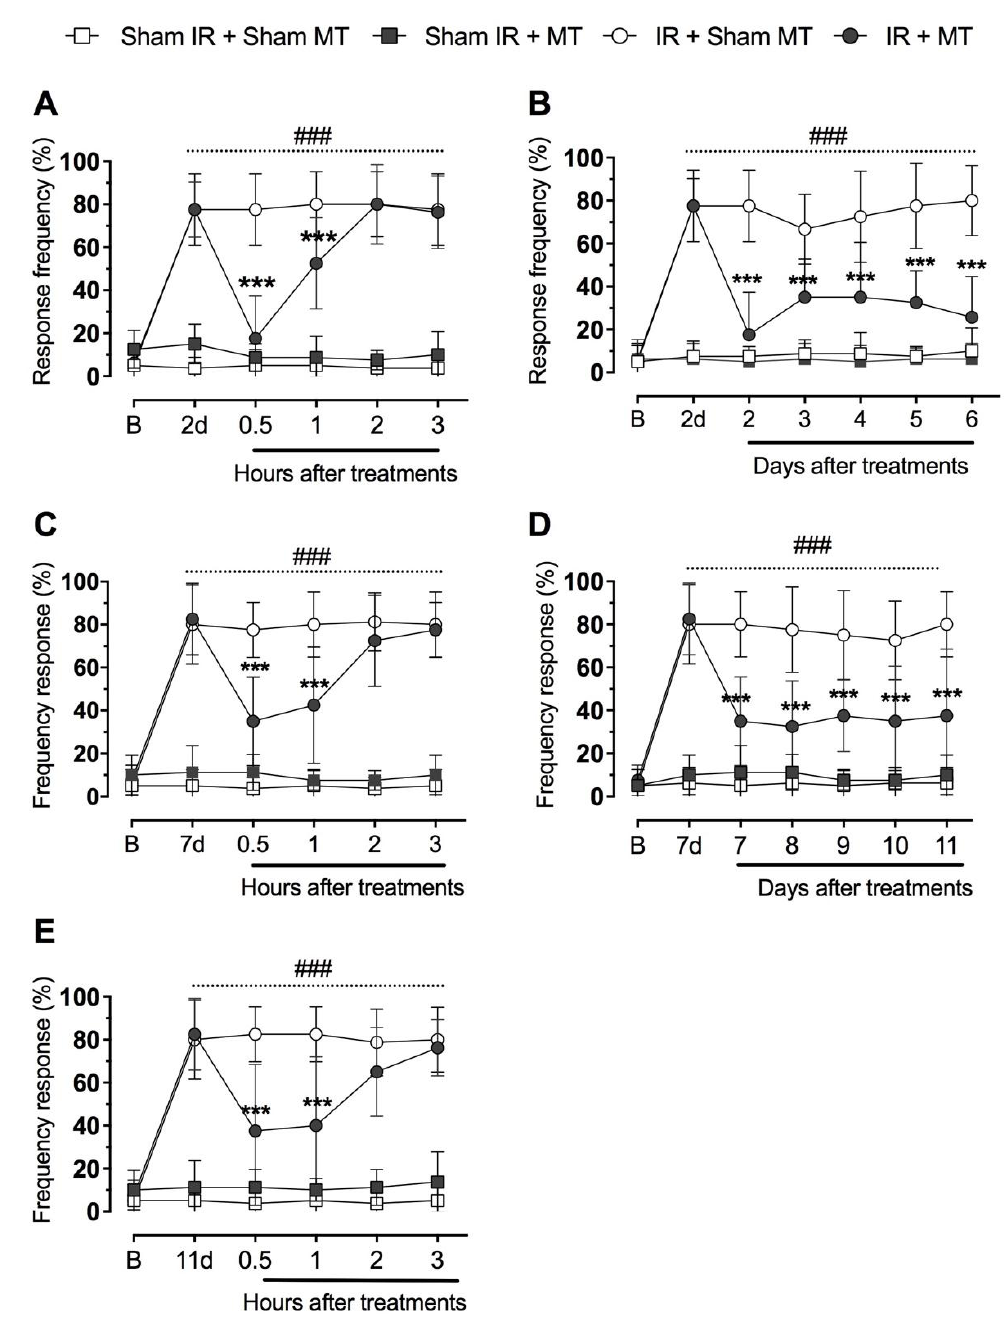
Figure 2. E ff ect of manual therapy (MT) on mechanical hyperalgesia. Time course analysis at the 2nd day (panel A ). Daily treatment with 9-minute ankle joint mobilization between the 2nd to 6th day after IR procedure (panel B ). Time course analysis at 7th day (panel C ). Daily treatment with 9-minutes of MT between the 7th to 11th day after IR procedure (panel D ). Time course analysis at 11th day (panel E ). Each point represents the mean of 8 animals and vertical lines show the SD. Statistical analyses were performed by two-way ANOVA followed by Bonferroni test. The symbols denote a significant di ff erence of *** p < 0.001 when compared to IR + Sham MT group or ### p < 0.001 when compared to Sham + Sham MT group. MT: Manual therapy, IR: Schemia and reperfusion.